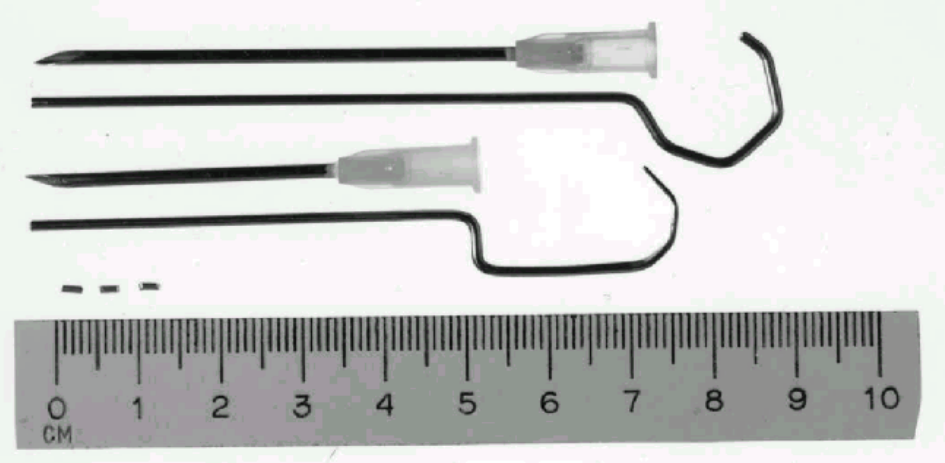
Figure 2. Three gold beads and two different sizes of 14 G needles together with their adapted